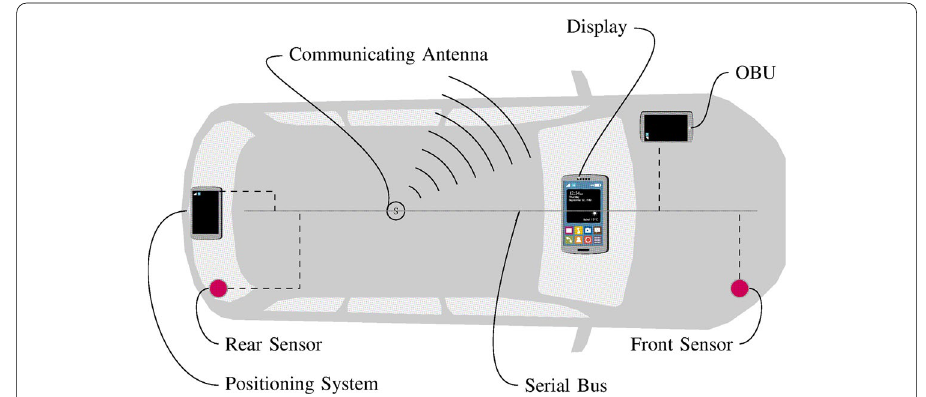
Fig. 2 Envisioned smart vehicle